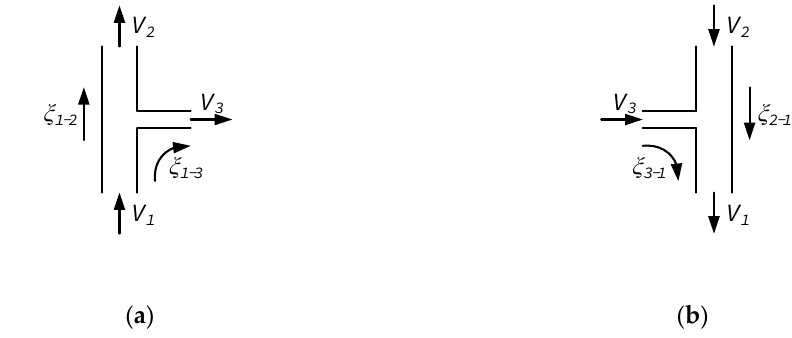
Figure 5. Schematic of the three-way connector. ( a ) Separate flow; ( b ) convergence flow.